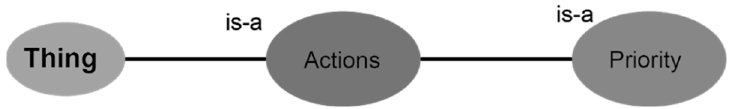
Figure 5. Action concept.